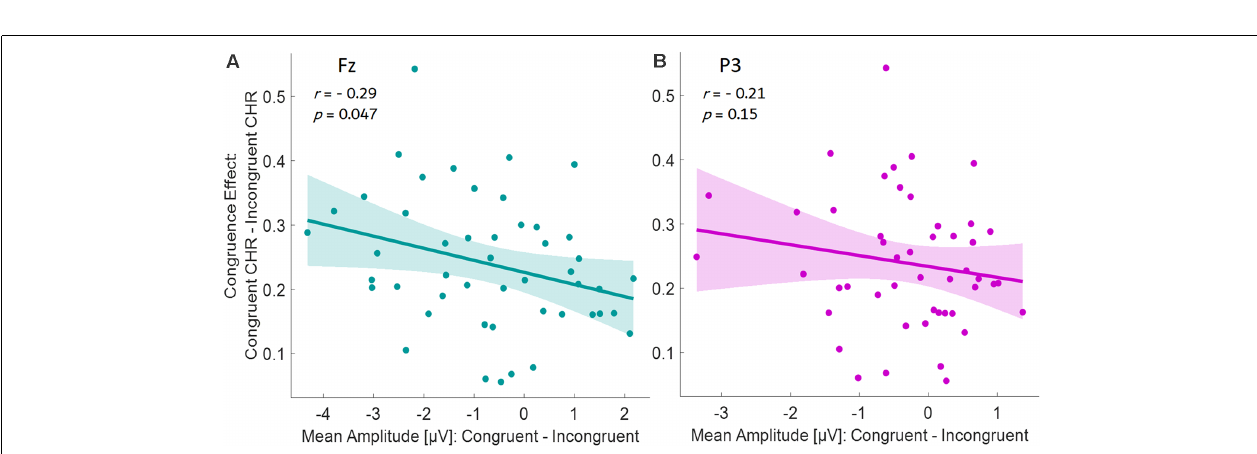
FIGURE 5 | TF Analysis for electrodes (A) Fz and (B) P3. For Fz, the theta frequency band (black rectangles) was analyzed from 4 to 8 Hz, from 100 to 250 ms, and the alpha frequency band (white rectangles) was analyzed from 10 to 14 Hz, from 200 to 600 ms, for young and older participants. For electrode P3 theta (black rectangles) was analyzed from 4 to 8 Hz, from 100 to 250 ms, and alpha (white rectangles) was analyzed from 10 to 14 Hz, from 400 to 700 ms, for young and older participants.